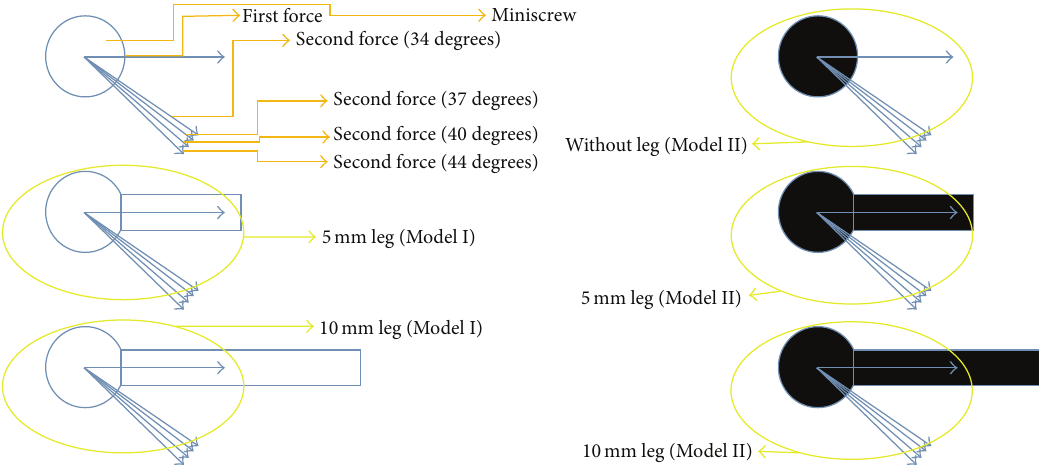
Figure 2: Representation of leg length and applied forces with a position angle ranging from 34 ∘ to 44 ∘